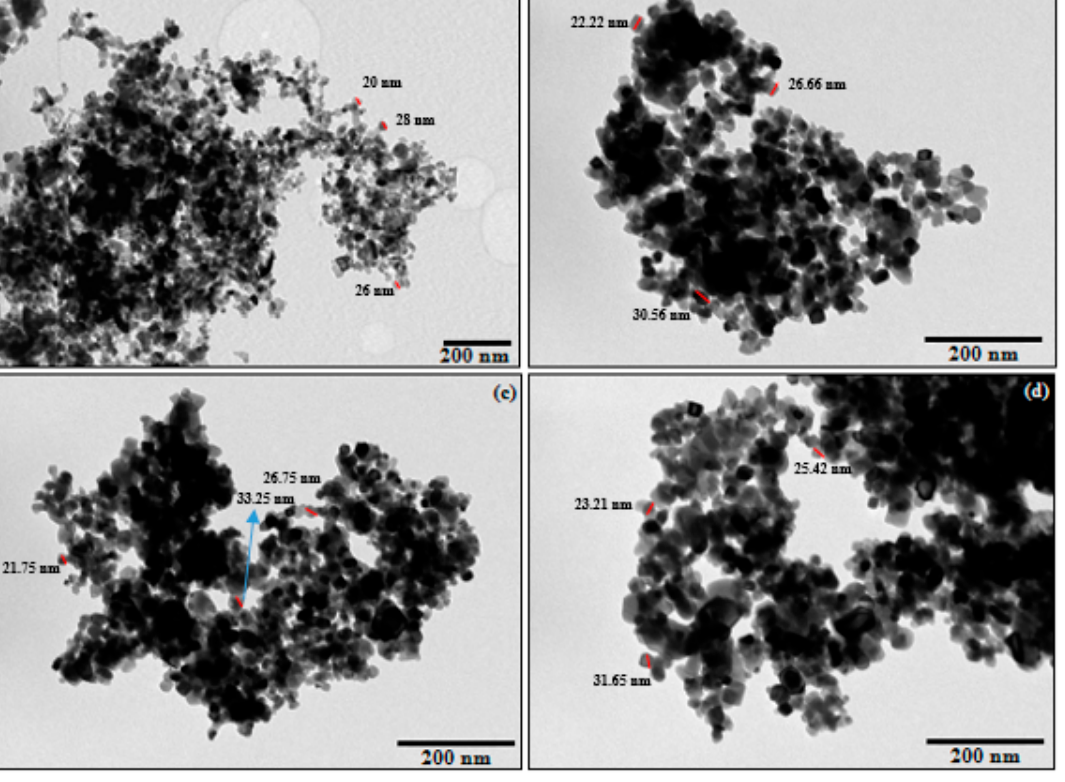
Figure 2. Transmission electron microscopy (TEM) micrographs of ( a ) TiO 2 –P25, ( b ) Cu(0.1%)/TiO 2 , ( c ) V(0.1%)/TiO 2 , and ( d ) Cr(0.1%)/TiO 2 .